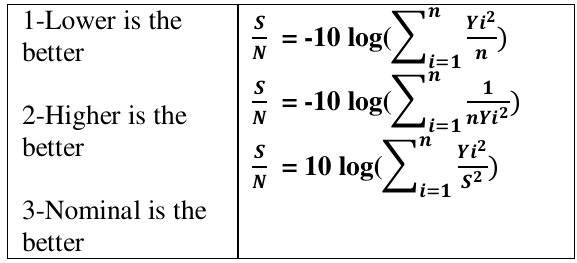
S/N Ratios Formulations